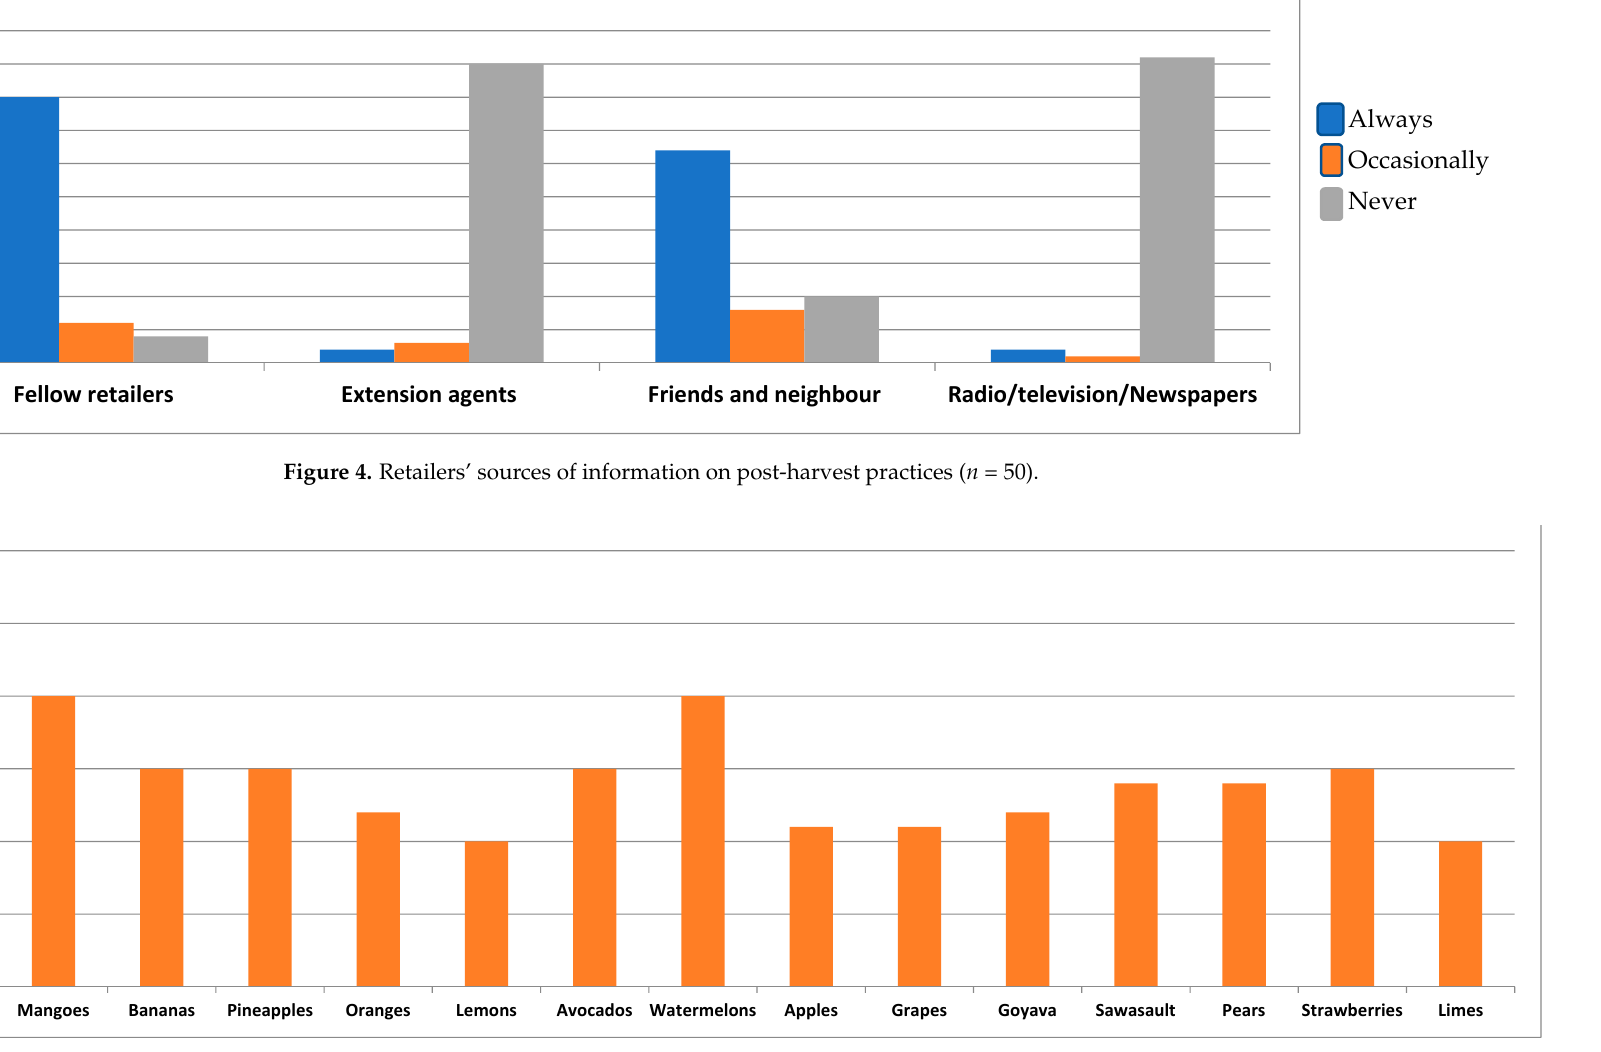
Figure 5. Estimation of fruit waste at the retailer level ( n = 50)..